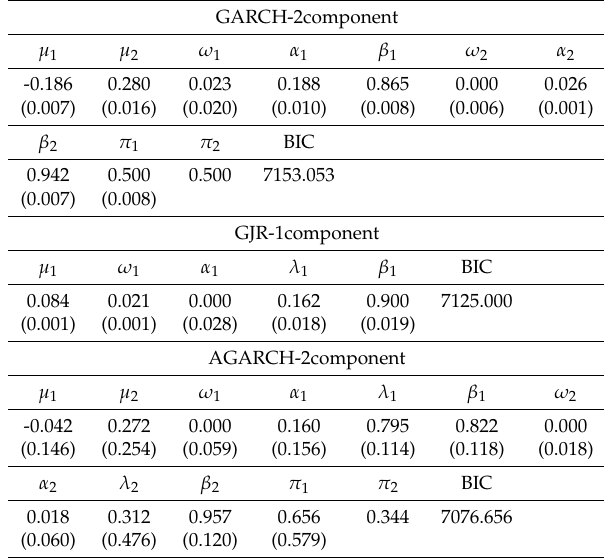
Table 4. Estimation of the Three Classes of GARCH(1,1) Families in the